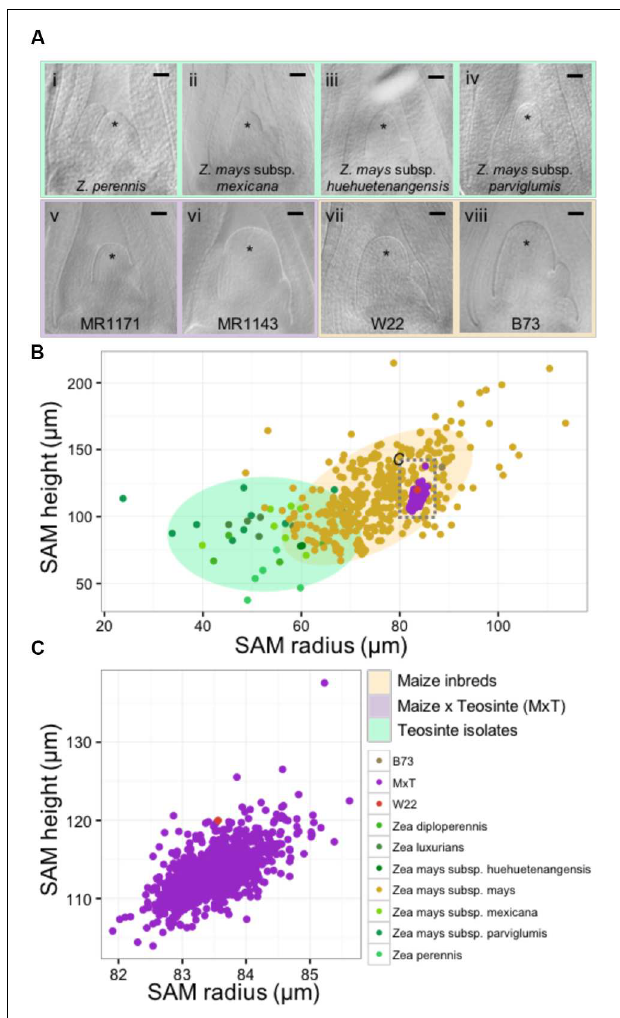
FIGURE 1 | The maize and teosinte shoot apical meristem (SAM) morphospace. (A) Median longitudinal images of shoot meristems from wild teosinte isolates (i–iv), large and small SAMs from the maize x teosinte (MxT) intercross (BC2S3) lines (v–vi), and maize inbred varieties W22 (vii) and B73 (viii). ∗ indicates SAM with flanking leaf primorida. Scale bar, 50 urn. (B) Quantification of meristem radius and height show that SAM morphology observed in teosinte varieties (greens) and maize inbred varieties (yellow) partially overlap but teosinte SAMs are generally smaller than maize inbred SAMs. Measures from MxT lines (purple) cluster closely around the recurrent maize parent, inbred W22 (pink). Gray dashed box, location of data in panel (C) . Shaded ellipses, 90% density estimation of SAM shape data. (C) Variation in SAM shape and size in MxT lines (purple) around the W22 maize inbred parent